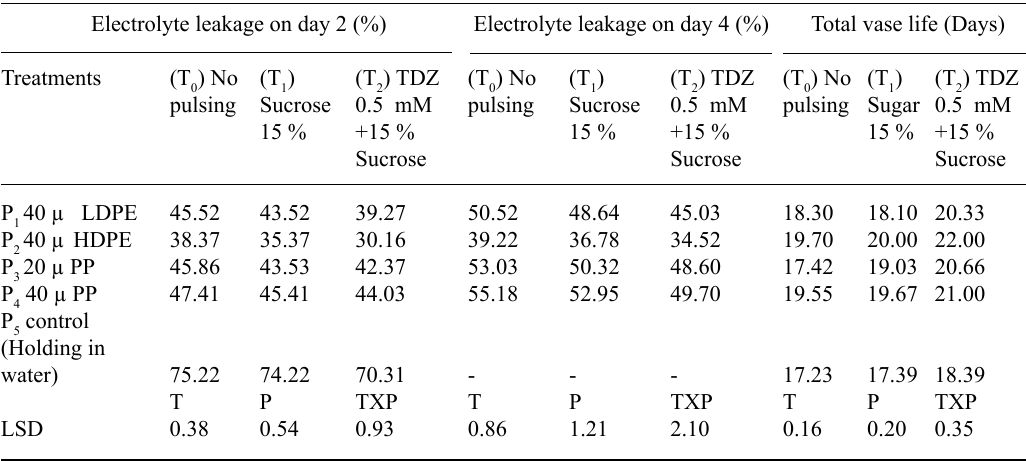
Table 4. Effect of pre-storage pulsing, packaging and storage at 2 o C on Electrolyte leakage 6 DAS and Total vase life by tuberose cut spikes cv.